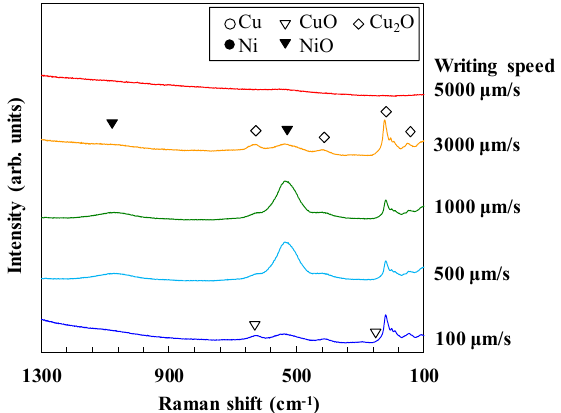
Figure 3. Raman shifts of the fabricated micropatterns.